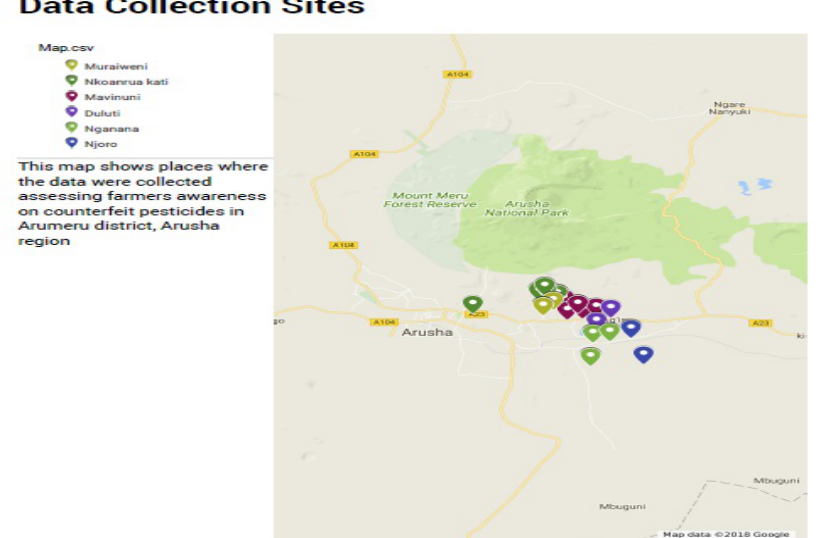
Figure 1. Data Collection